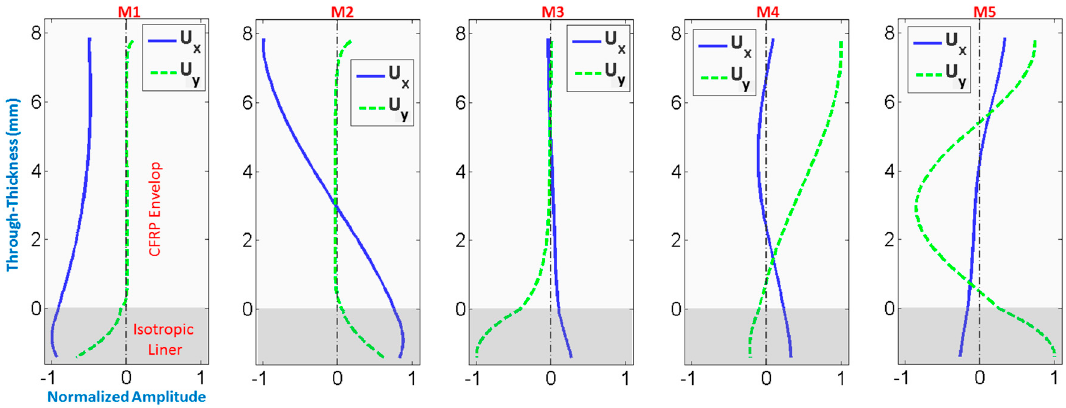
Figure 5. Mode shapes calculated for a specific case of COPV (2 layers having thicknesses 7.85 mm and 1.39 mm respectively) at around 180 kHz for Modes 1 through 5, from left to right.